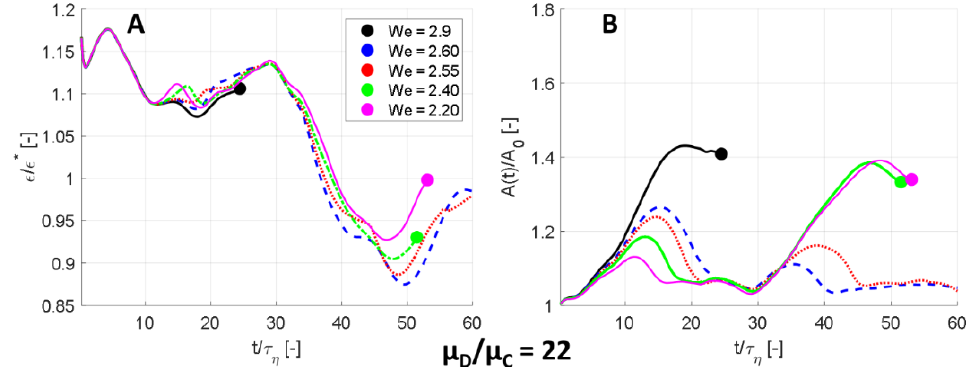
Figure 11. Suppression of turbulence for an intermediary viscosity drop ( µ D / µ C = 22). ( A ) Dissipation rate of TKE, ε , normalized to the one-phase flow time-averaged value, ε * , as a function of time, t . ( B ) Total interfacial area, A , normalized with its initial value, A 0 .